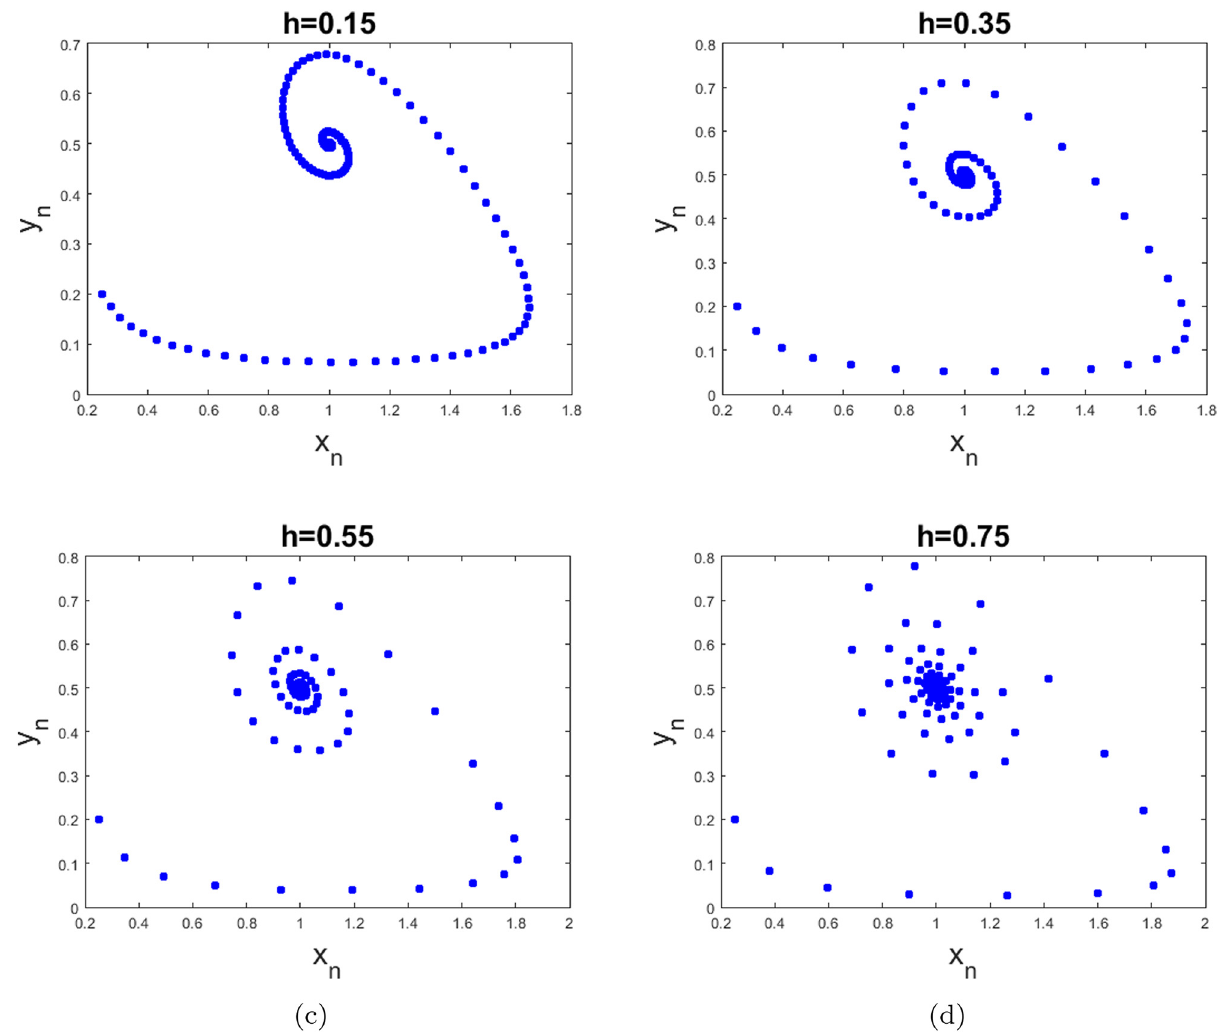
Figure 3: Stable dynamical behavior of system ( 8 ) subject to the initial condition ( ( ) ( )) ( ) = x 0.25, 0.2 for the